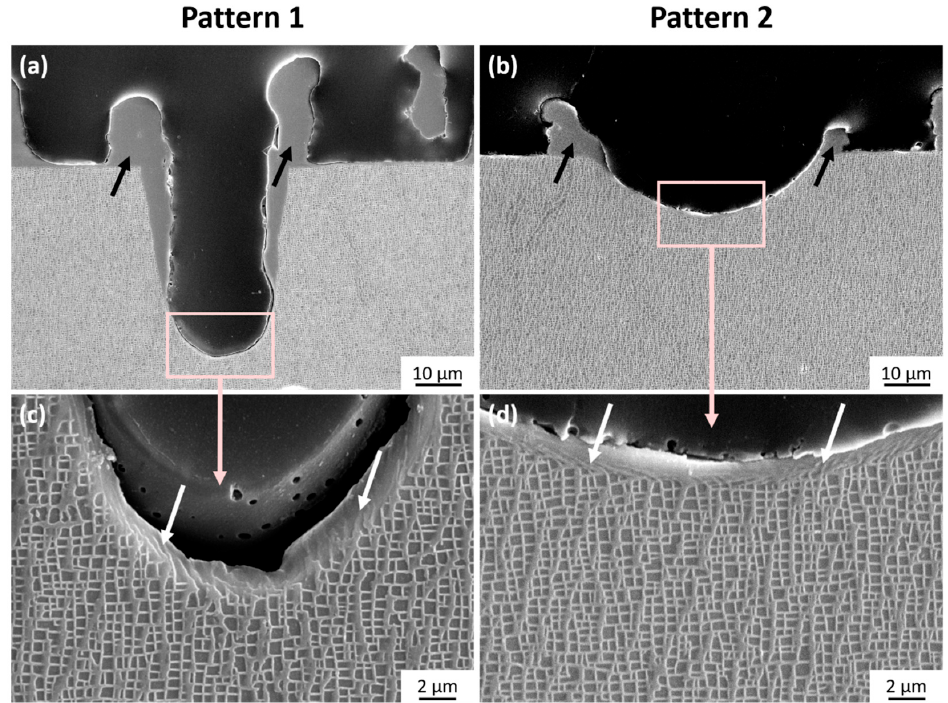
Figure 4. Microstructure of AM1 + AgT: ( a ) pattern 1, ( b ) pattern 2, ( c ) hole bottom of pattern 1 and ( d ) hole bottom of pattern 2. Black and white arrows underline generated asperities and heat-affected areas, respectively, in the hole bottoms.